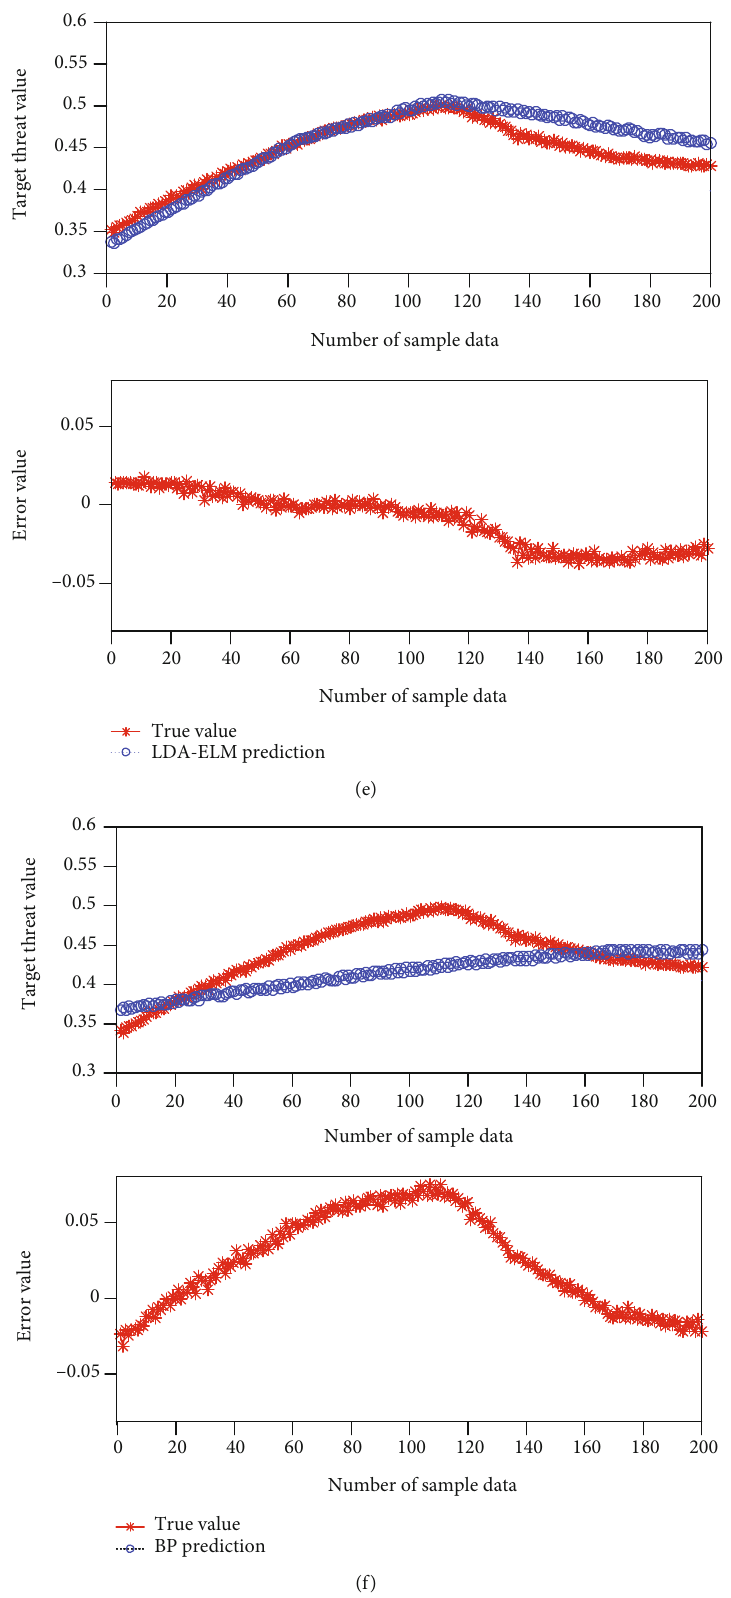
Figure 7: Simulation results of test samples: (a) LDA-IGSO-ELM prediction; (b) GSO-ELM prediction; (c) ELM; (d) LDA-BP prediction; (e) LDA-ELM prediction; (f) BP